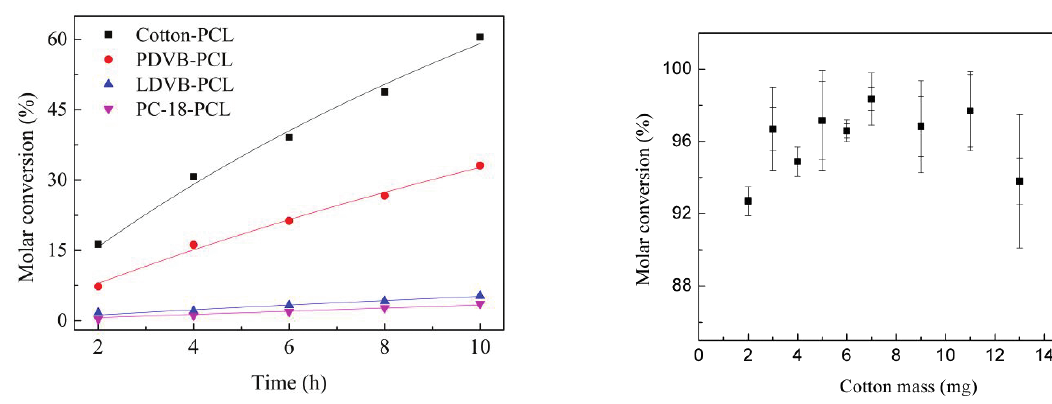
Figure 3: Molar conversion of hexanol reacting with vinyl acetate catalyzed by cotton-PCLs (10 mg PCL and 2-15 mg